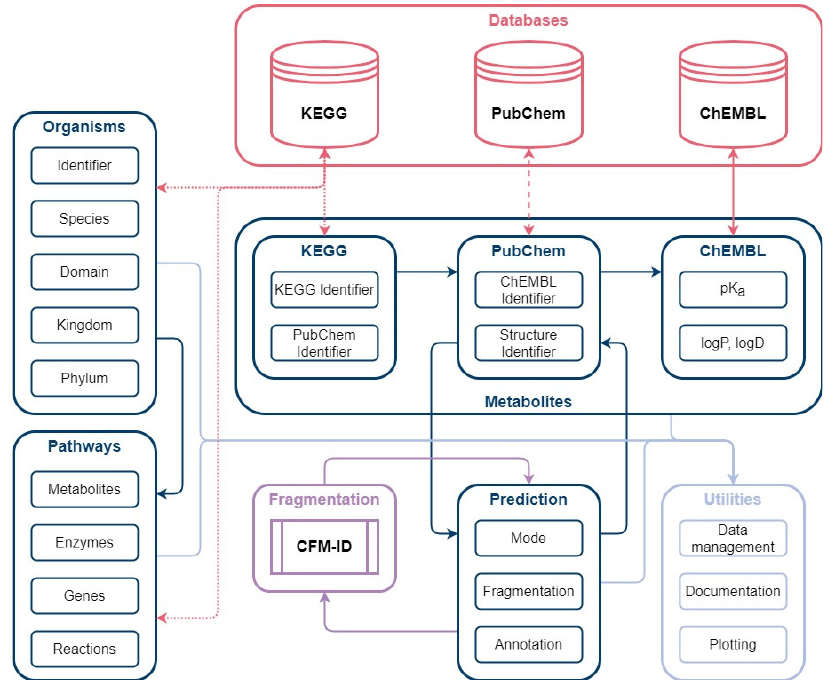
Figure 8. Automated database creation workflow: The workflow consists of the main modules Organisms, Pathways, Metabolites and Prediction. Organism identifiers from KEGG are used to gather organism and pathway-specific information in the form of metabolites, enzymes, genes. The Metabolites package is used to collect metabolite classification from KEGG, structure identifier from PubChem, and pK a values from ChEMBL. Based on the structure identifier (SMILES), prediction of MS/MS spectra are conducted with CFM-ID.